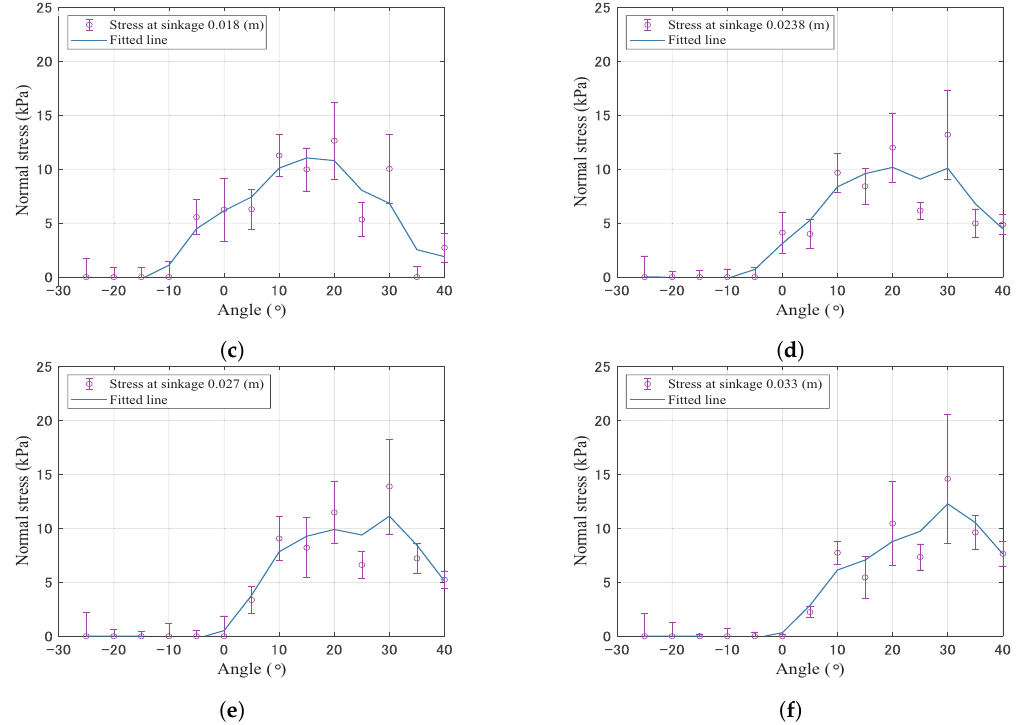
Figure 14. Mean ± SD normal stress at each sinkage and contact angle. Each distribution shows the data when the sensor position θ e was 0 ◦ . ( a ) Sinkage 0.013 (m) θ e = − 20 ◦ , ( b ) Sinkage 0.015 (m) θ e = − 15 ◦ , ( c ) Sinkage 0.018 (m) θ e = − 10 ◦ , ( d ) Sinkage 0.0024 (m) θ e = − 5 ◦ , ( e ) Sinkage 0.027 (m) θ e = 0 ◦ , ( f ) Sinkage 0.033 (m) θ e = 0 ◦ . Table 5. The smallest contact angle at each sinkage level measured by PIV